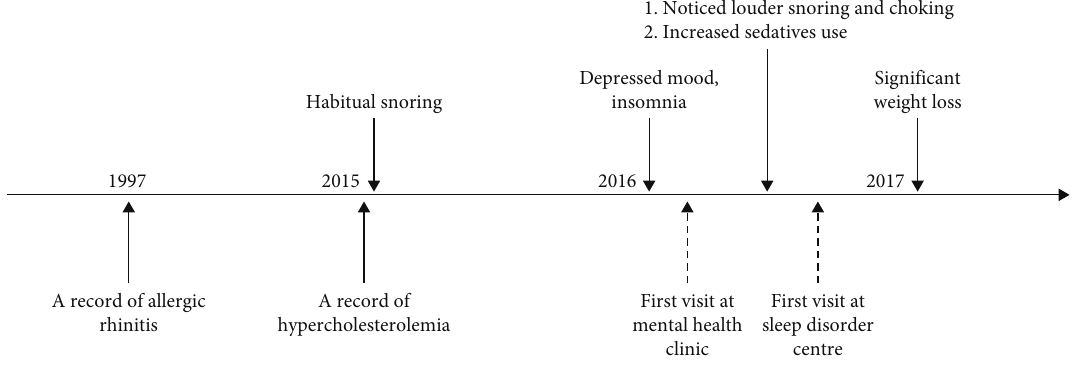
Figure 1: Timeline of essential medical